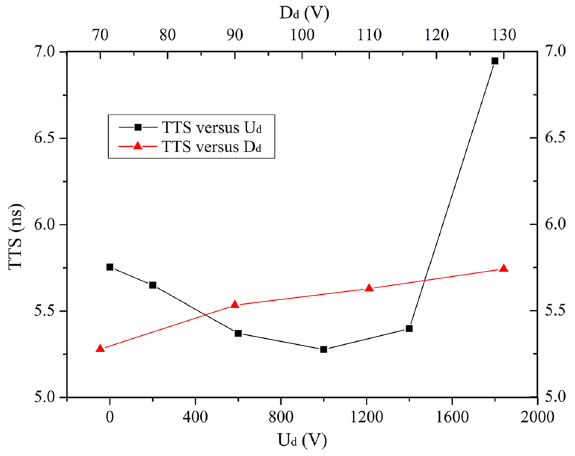
Figure 7. TTS versus U d and D d over the ranges of 0 V ≤ U d ≤ 2000 V and 70 mm ≤ D d ≤ 130 mm.